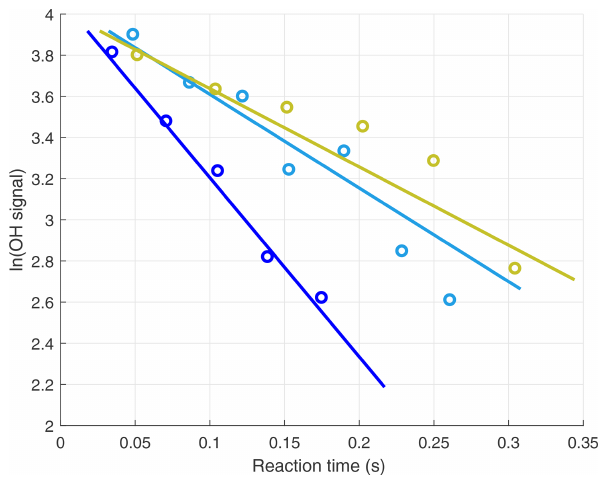
Figure 3. Three in-flight decays for 1min sums of the OH signals. Decays were measured in the marine boundary layer, and the in- dividual 5Hz data were binned by reaction times for clarity. When k offset is subtracted from the decays, their values become ∼ 5 (blue), ∼ 3(teal), and ∼ 2 (yellow)s − 1